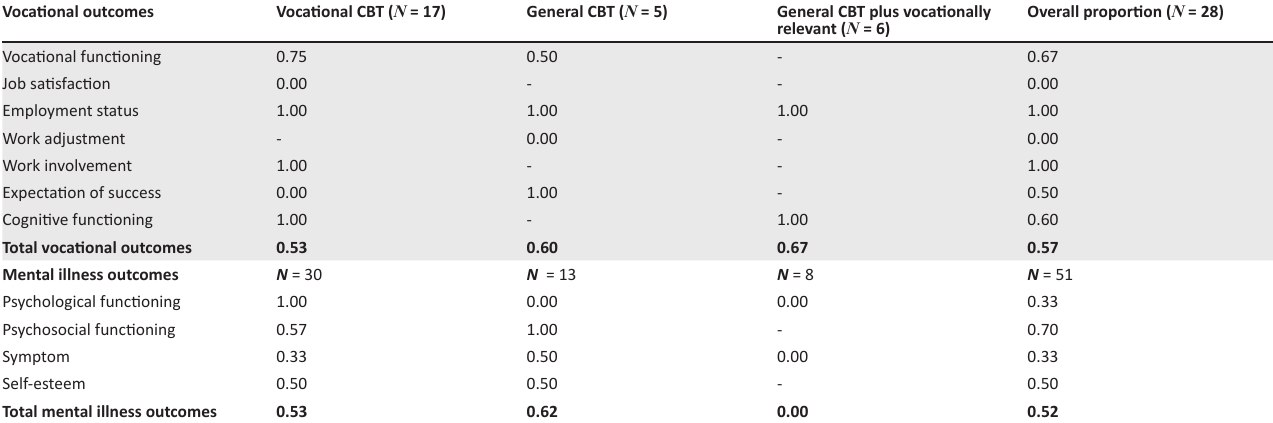
TABLE 2: Proportion of vocational outcome studies and mental illness outcome studies that had significant effects. Vocational